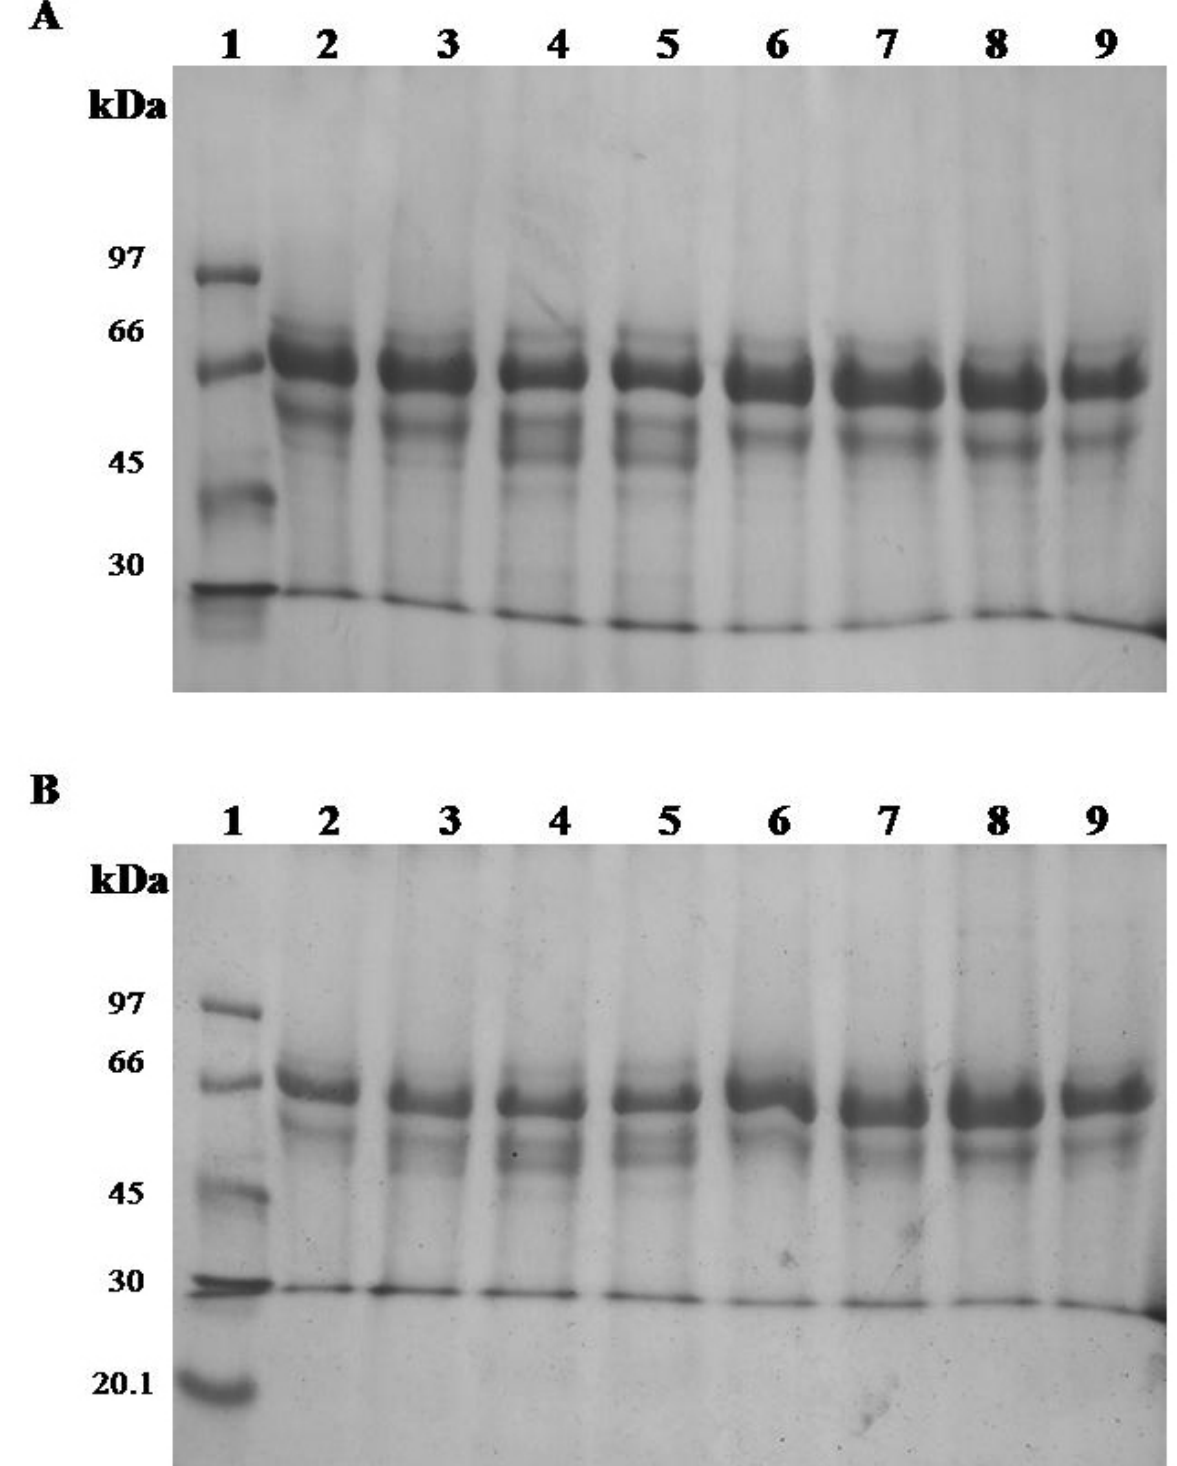
Figure 3. Protein profile of ( A ) L. amazonensis (PH8) and ( B ) L. braziliensis (M2903) by SDS-PAGE (14%) in reduced condition after treatment. Lane 1: standard proteins; lanes 2 and 3: Leishmania without treatment; lanes 4 and 5: treatment with B. moojeni crude venom (25 µg); lanes 6 and 7: treatment with B. moojeni venom E5 fraction (5 µg); lanes 8 and 9: treatment with amphotericin B (25 µg). The gel was stained with Coomassie blue R-250. The results presented are representative of three other experiments performed